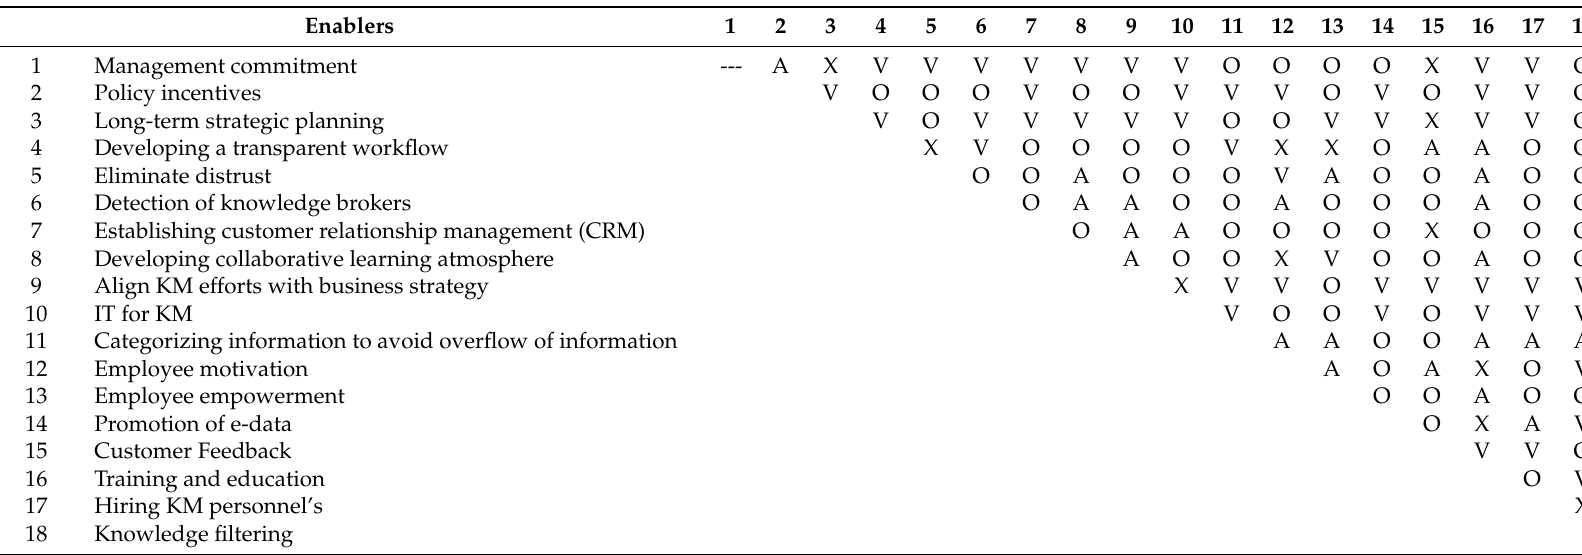
Table 2. Structural Self-Interaction Matrix for enablers of knowledge management implementation in the healthcare sector of Pakistan. Enablers Management commitment